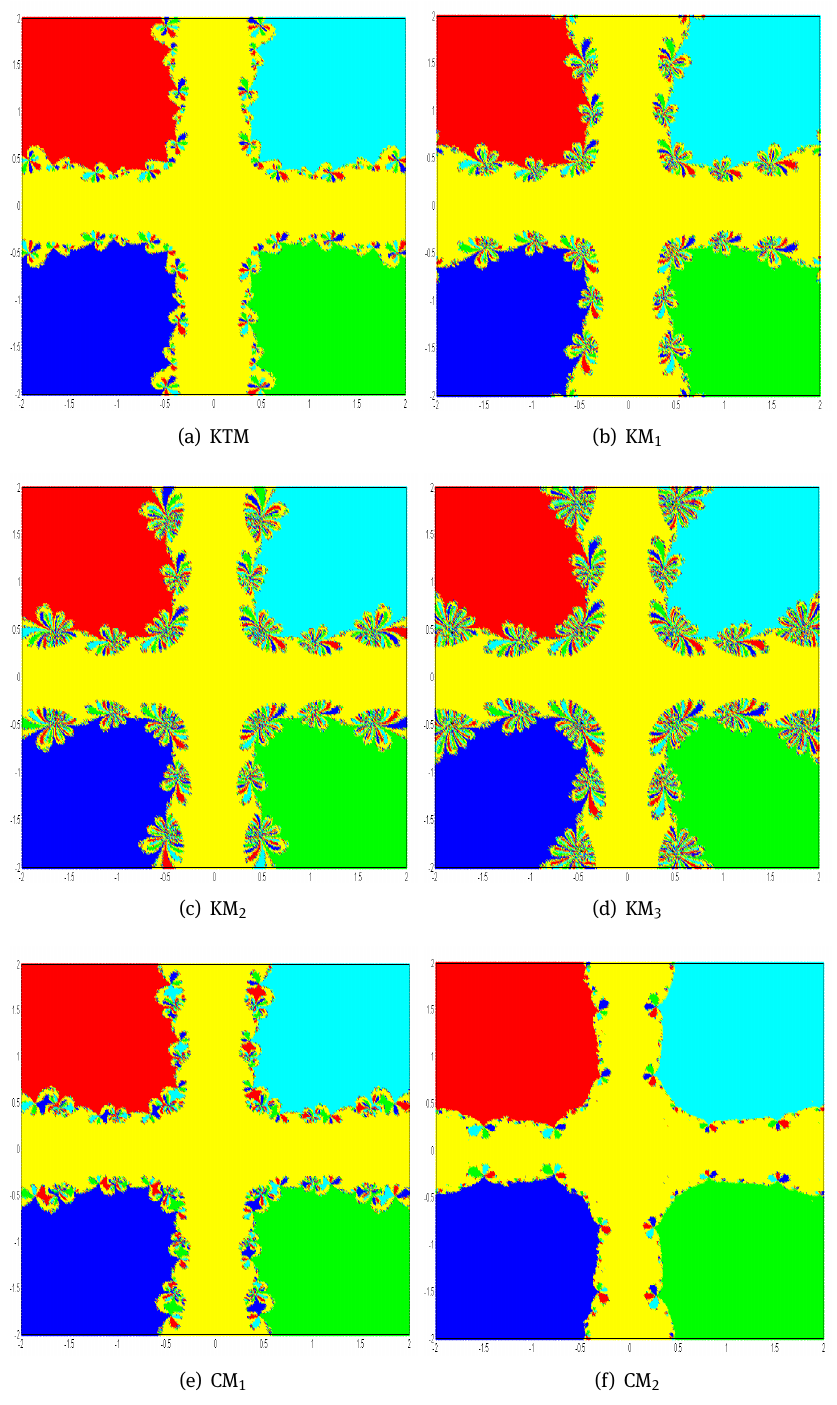
Figure 4: Basins of attraction of the methods KTM, KM 1 , KM 2 , KM 3 , CM 1 and CM 2 respectively for P 2 ( z ) = z 5 + z